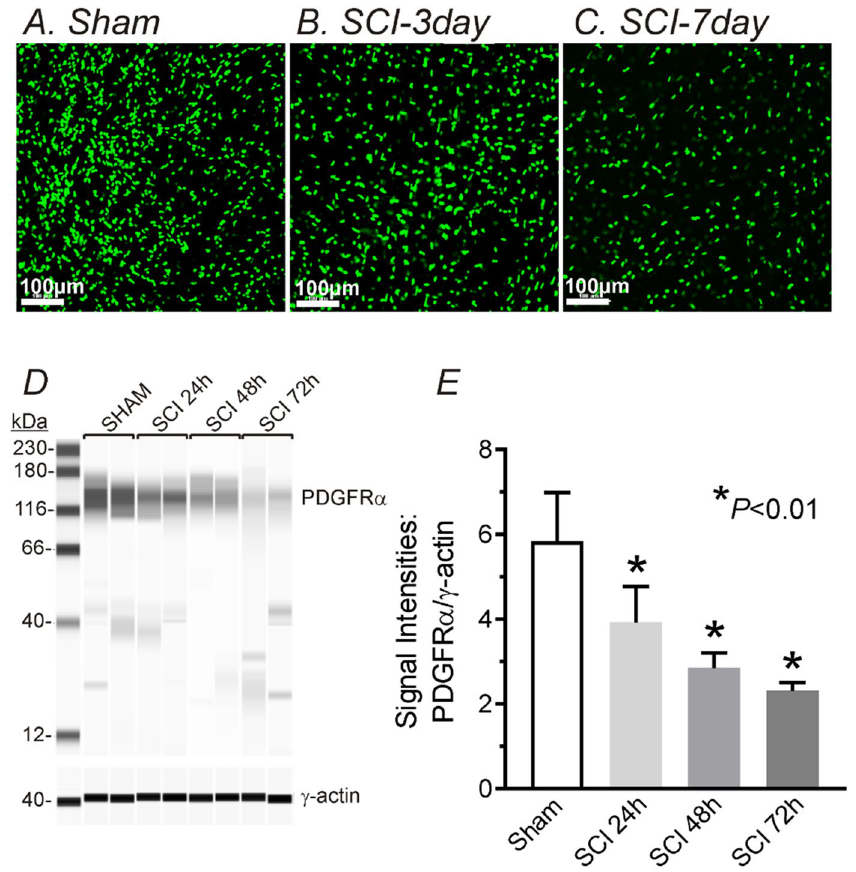
Figure 3. Density of PDFGRα/eGFP cells and microcapillary electrophoresis and immunodetection of PDGFRα by WES in control and SCI detrusor muscles. (A–C) Far fewer eGFP + nuclei (reporter for PDGFRα + cells) were found in detrusor muscles after SCI. ( D) Representative Wes full length gel image of PDGFRα expression in murine detrusor muscles following SCI. 100,000 × g pellet, 1 µg/lane, γ-action was used for normalization. ( E) Normalized signal intensities of PDGFRα by g-actin following SCI